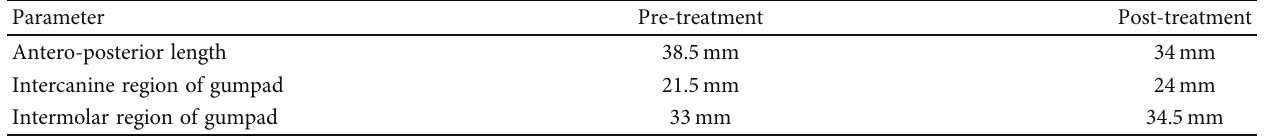
Table 1: Comparative values of pre- and post-3D Versascrew appliance model